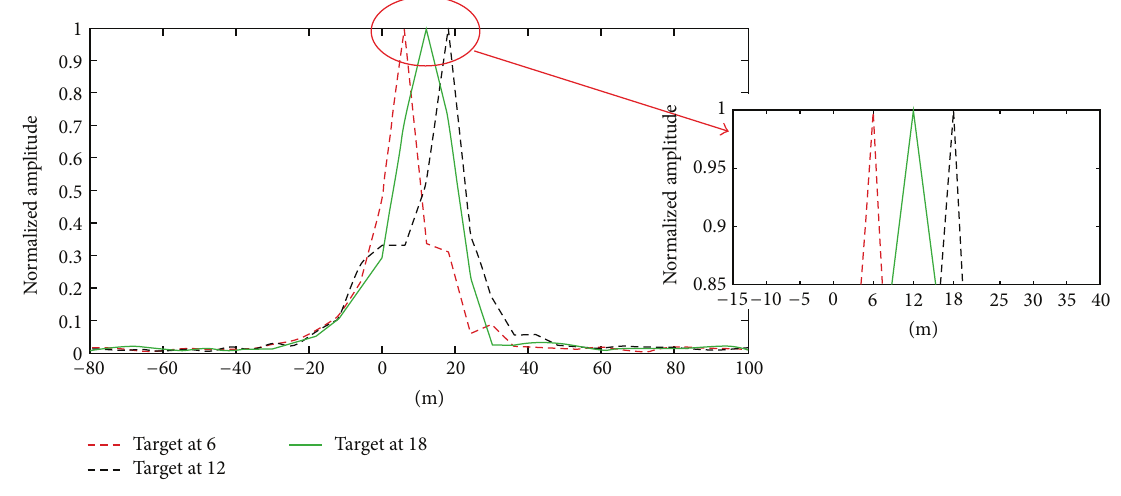
Figure 8: Retrieved signal peaks for different target positions.